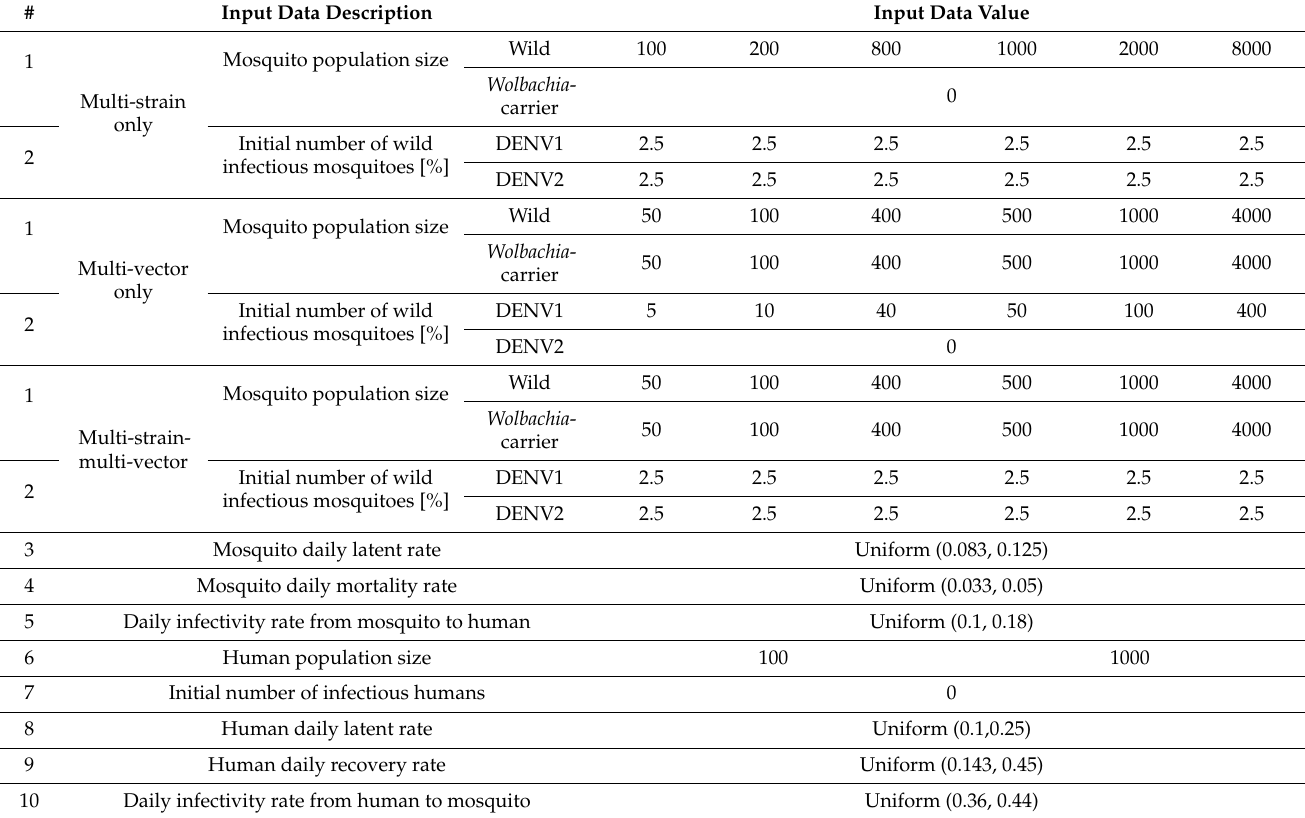
Table 7. Input parameter values of the simulation Model